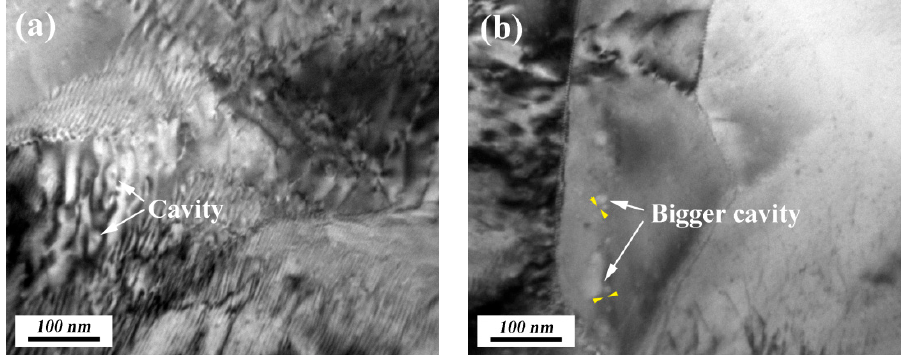
Figure 5. ( a ) dislocation-cavity interaction, 10 16 ions·cm − 2 ; ( b ) bigger cavity, 10 16 ions·cm − 2 .